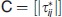
HC graphs: (a) dendrogram; (b) visualization tree.The matrix C=[|τij*|] is used.